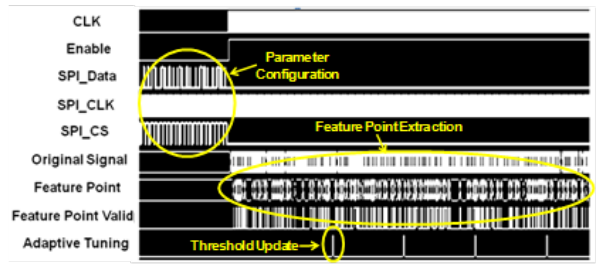
Figure 7. Operation waveform from post-layout simulation.